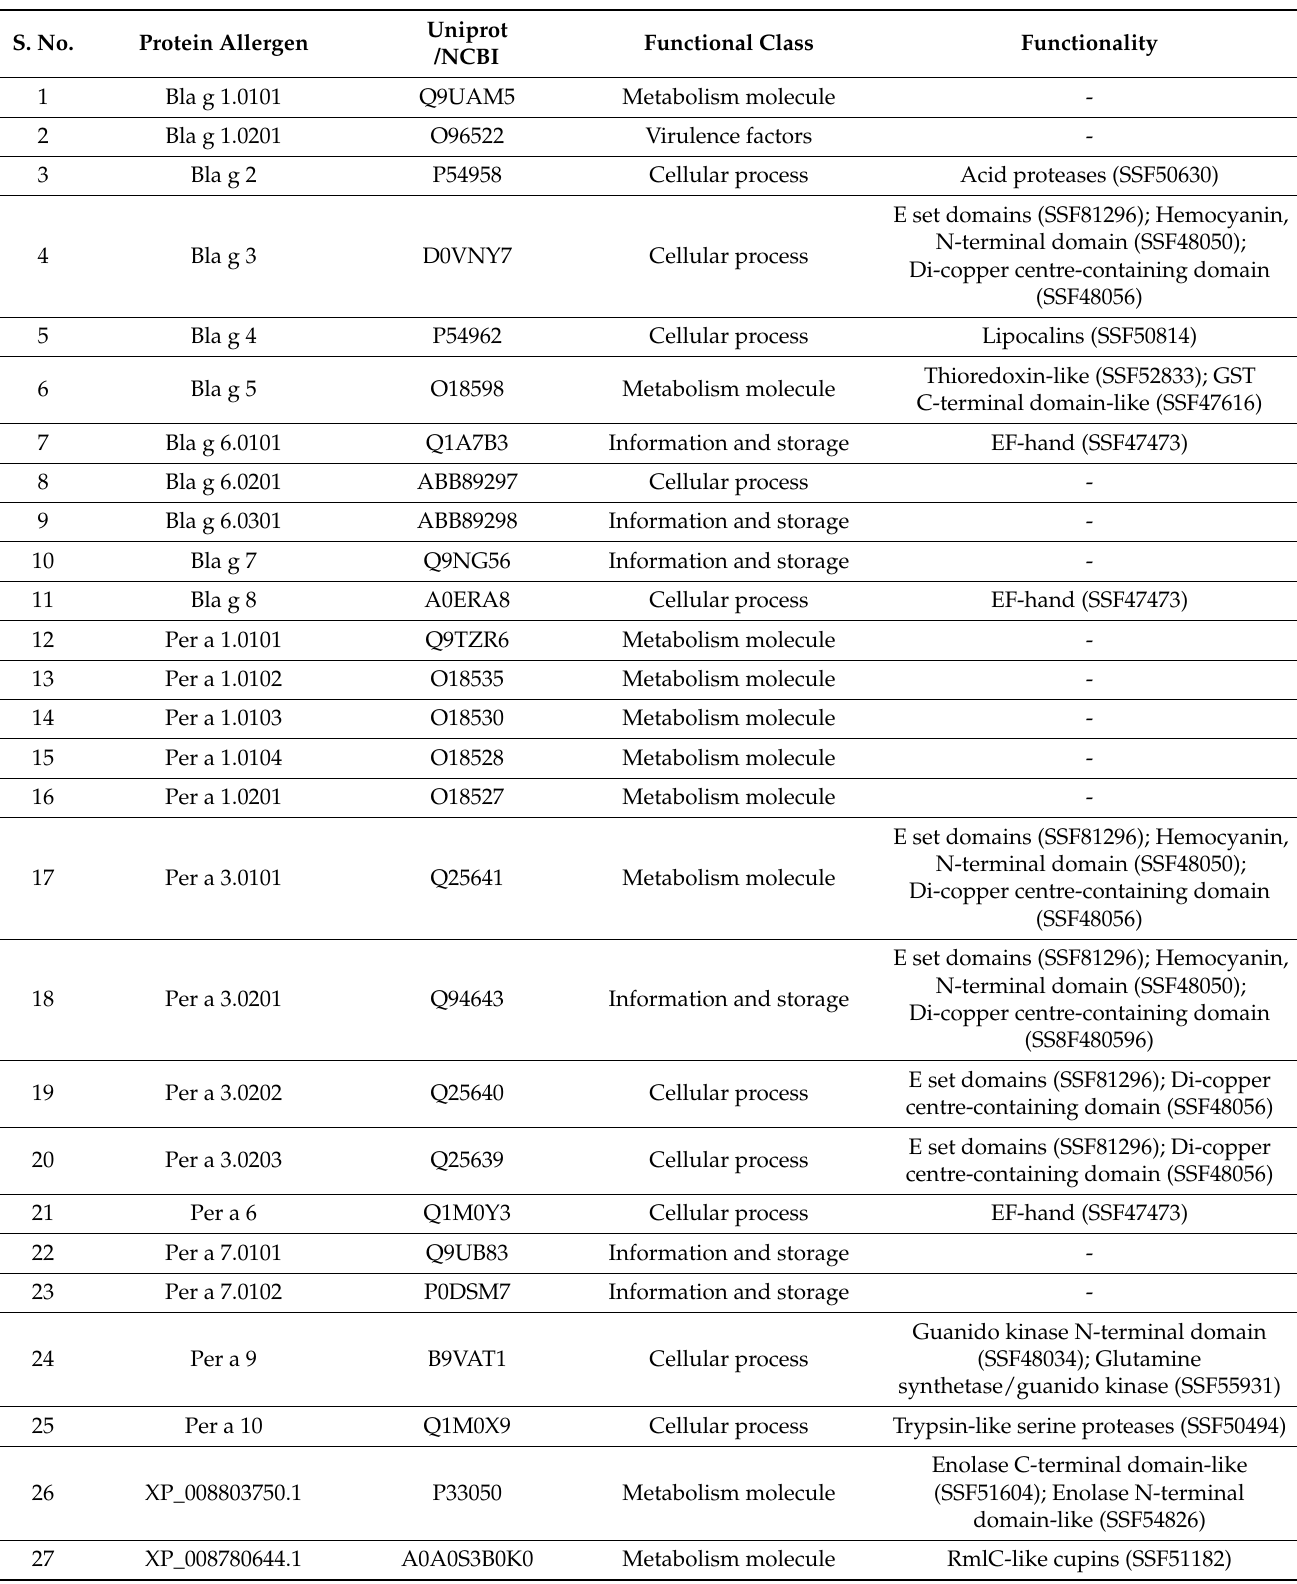
Table 2. Listing of primary protein sequences in functional